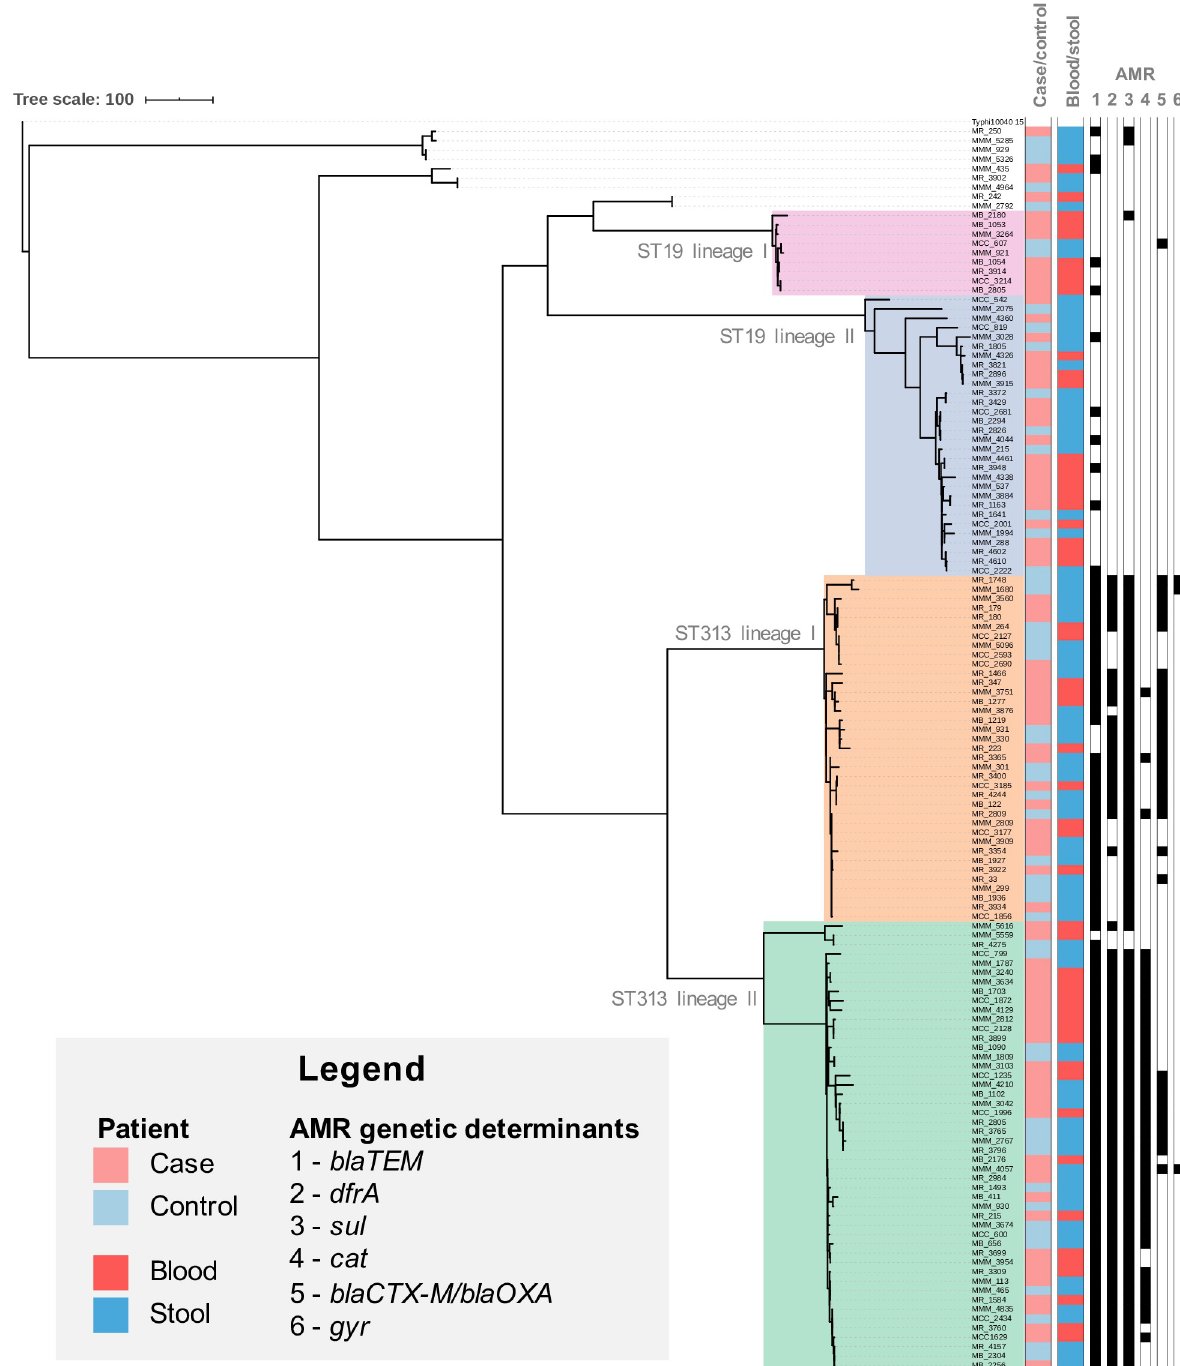
Fig 2. Phylogenetic tree of S . Typhimurium isolates from this study. Maximum likelihood phylogenetic tree based on the 130 S . Typhimurium genome sequences from this study. Sequencing reads were mapped to S . Typhimurium ST313 lineage II reference strain D23580, and S . Typhi 10040_15 was added as an outgroup to root the tree. The tree is based on 61161 chromosomal SNPs. Patient state (case/control) and the source (blood/stool) is visualized as indicated in the legend. Presence of multidrug resistance markers (MDR; bla , dfrA , sul , cat ), blaCTX-M/blaOXA antimicrobial resistance markers and SNPs in gyr are annotated. Branch lengths represent numbers of SNPs as indicated in the scale bar.